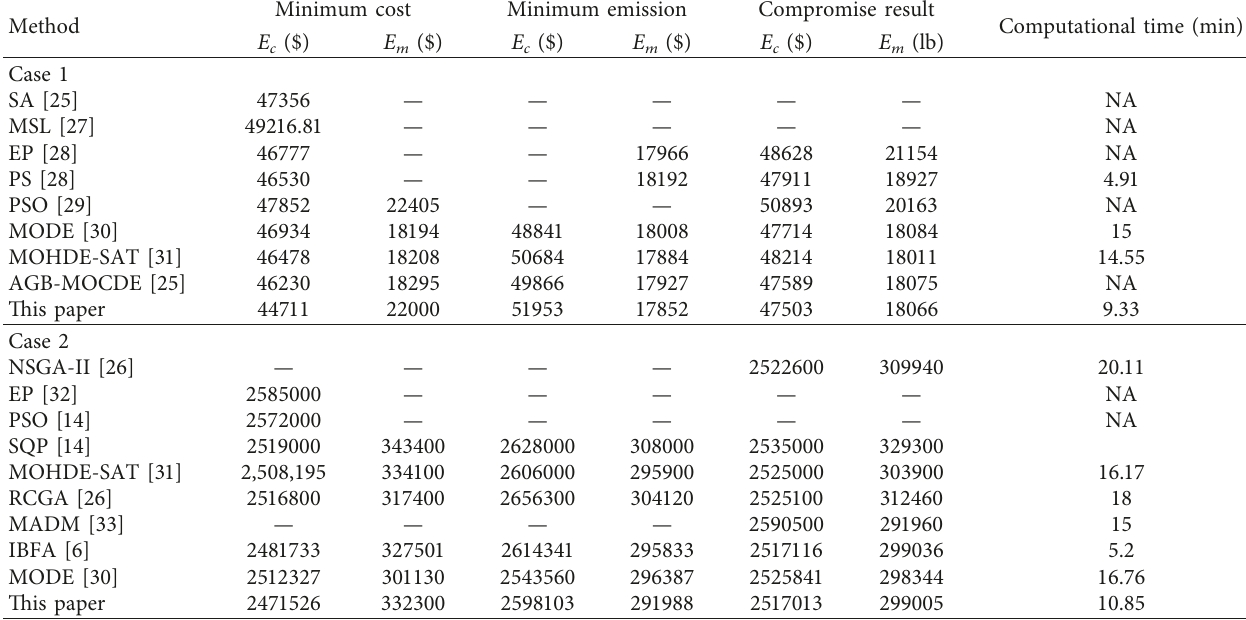
Table 5: Comparison of the results for Case 1 and Case 2.